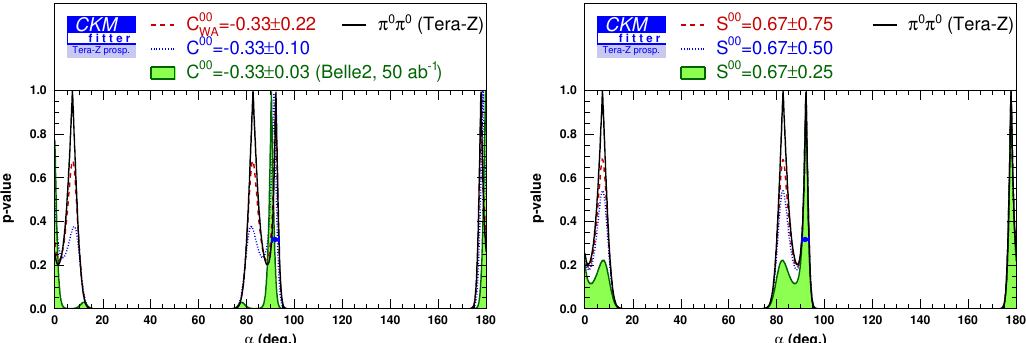
Figure 17 . p -value for α from B → ππ measurements within the scenario 1 improving only neutral modes without the current measurement of C 00 (black solid line). On the left: with additional CP information on C 00 with increasing precision up to 50 ab − 1 Belle II prospects (dashed red, dotted CP blue, solid green). On the right: with additional information on S 00 with increasing precision CP (dashed red, dotted blue, solid